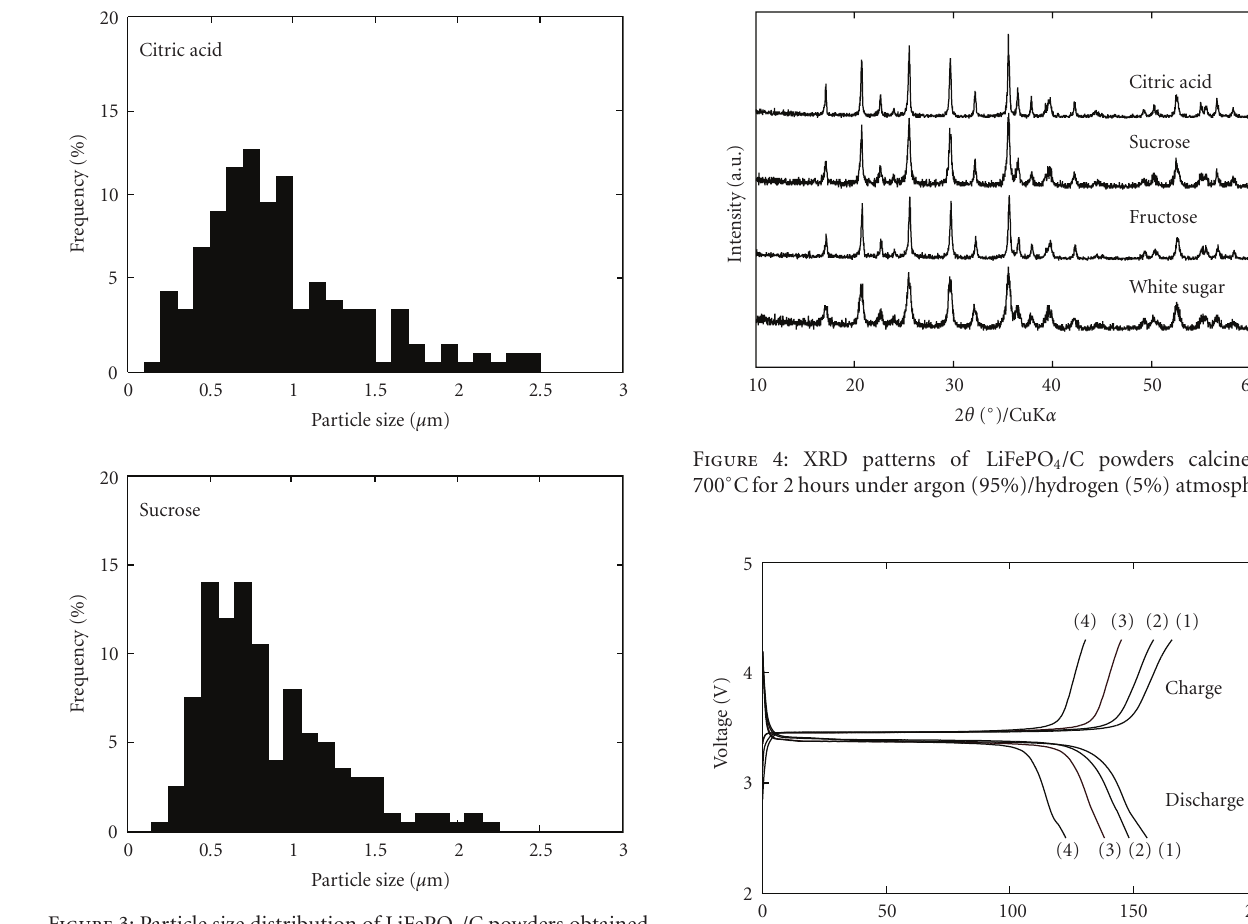
Figure 3: Particle size distribution of LiFePO 4 /C powders obtained from sucrose and citric acid.